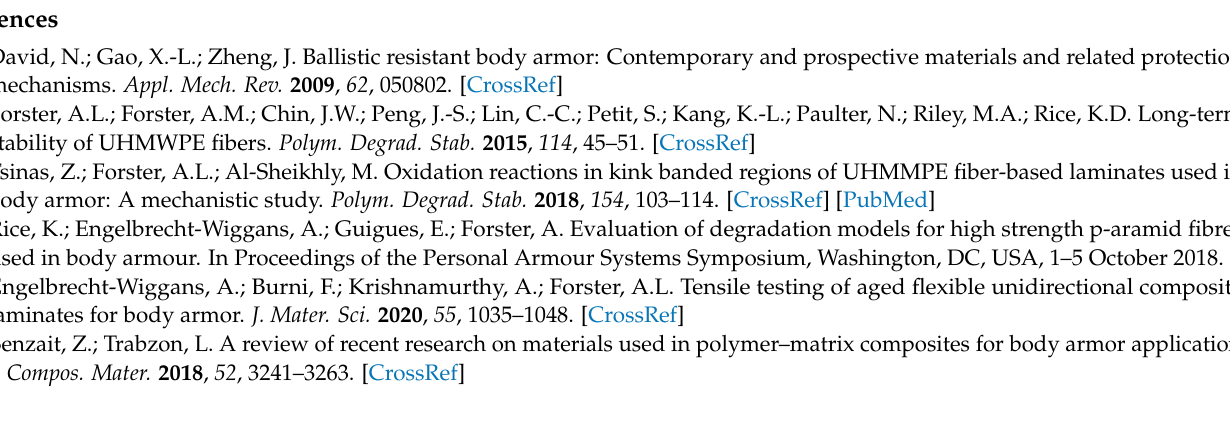
Figure A1. Load vs. strain for aged cyclic-tested specimen with 335 d at 70 °C in a desiccator (dry) on top and 336 d at 70 °C and 76% RH on bottom. Left plots the whole loading, middle the superimposed loading portions of the curves, and right the superimposed unloading portions of the curves.